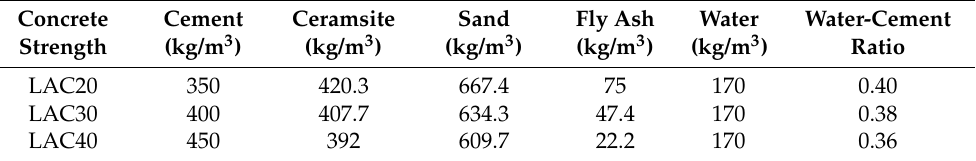
Table 2. Mix proportion of lightweight aggregate